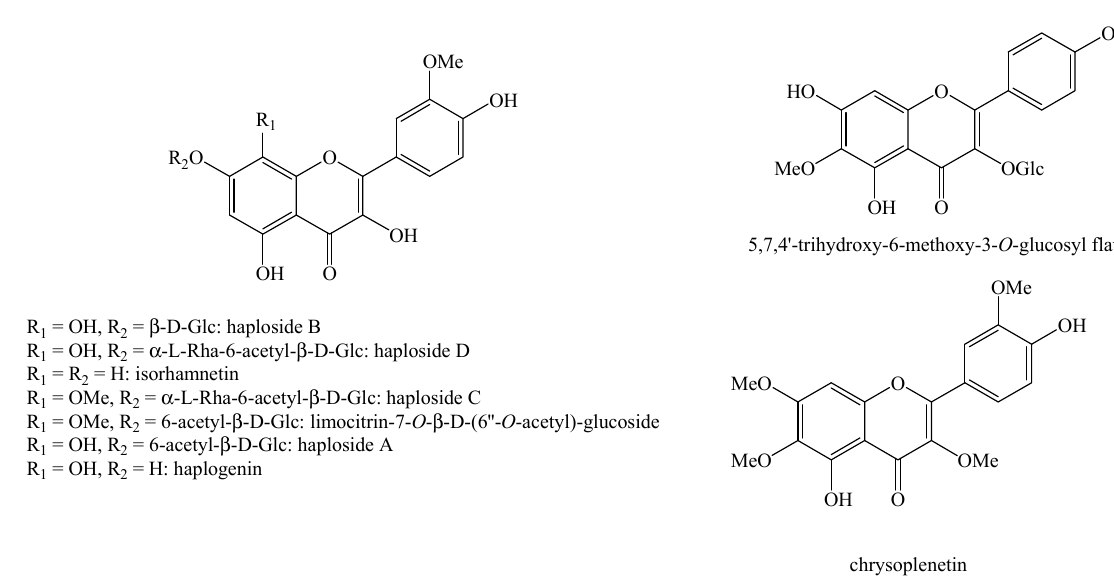
Figure 13. Structure of the flavonoids identified in Haplophyllum species.